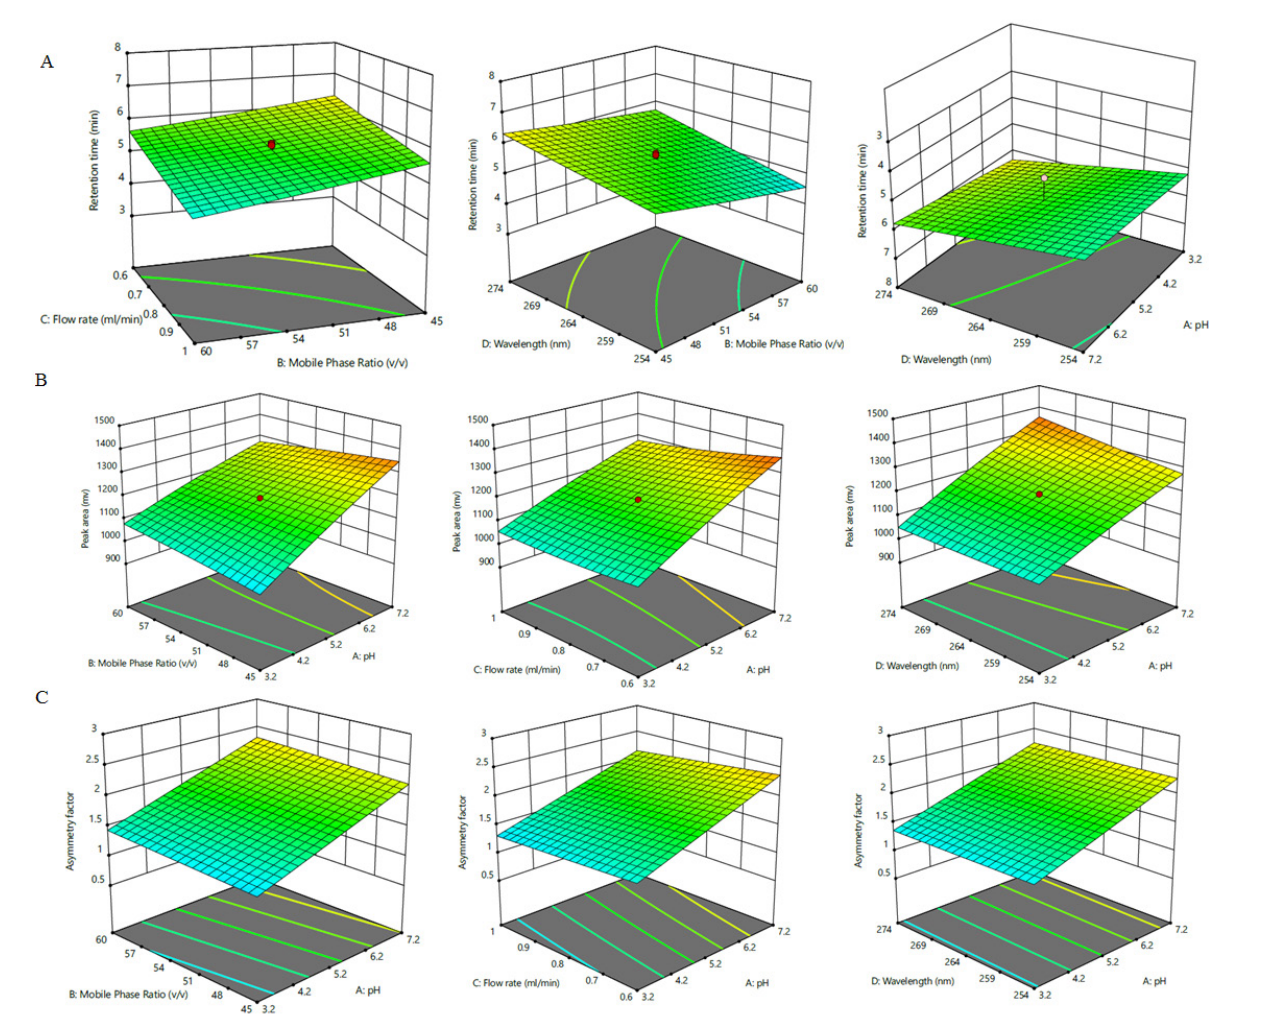
FIGURE 2 - 3D Response surface plots depicting the influence of independent variables on